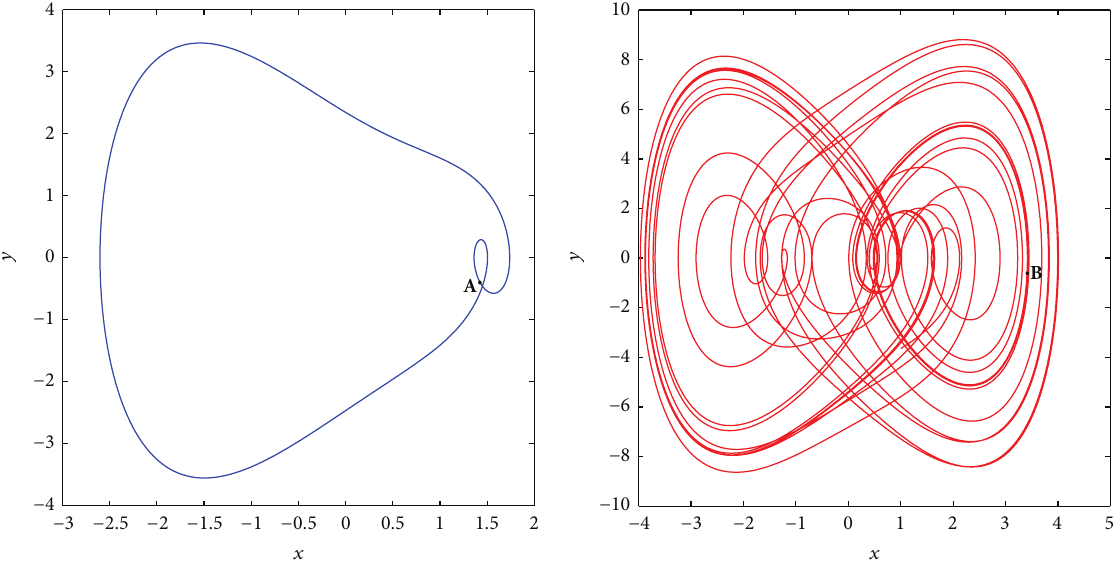
Figure 6: It illustrates the phase plane with the initial value point A (stable) in the left panel and shows the phase plane with the initial value point B (unstable) expressed in (37) in the right